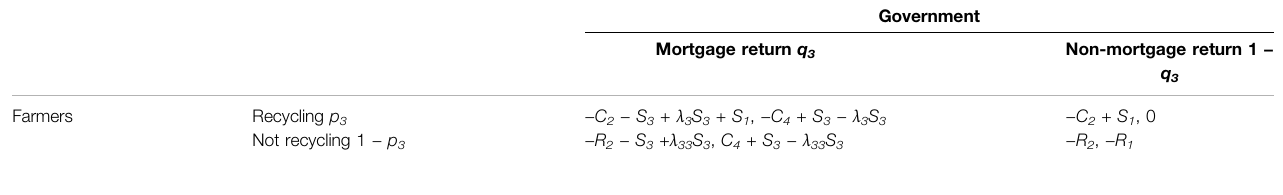
TABLE 3 | Game revenue matrix between farmers and government under the intervention mechanism of mortgage